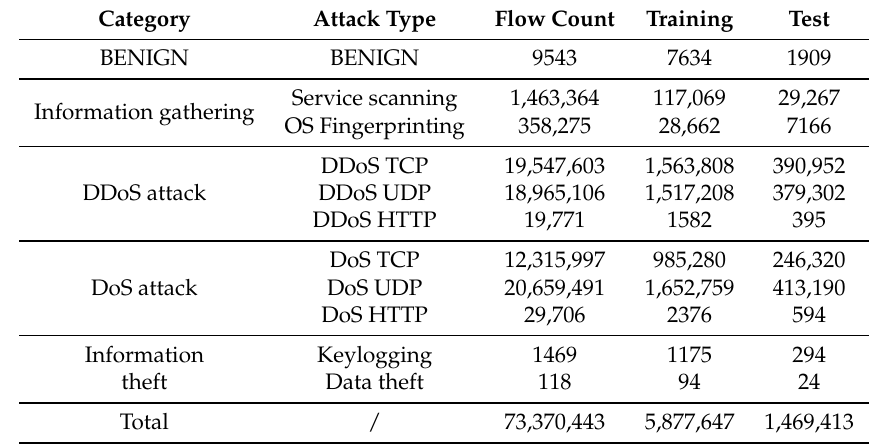
Table 3. Attack Types in Bot-IoT